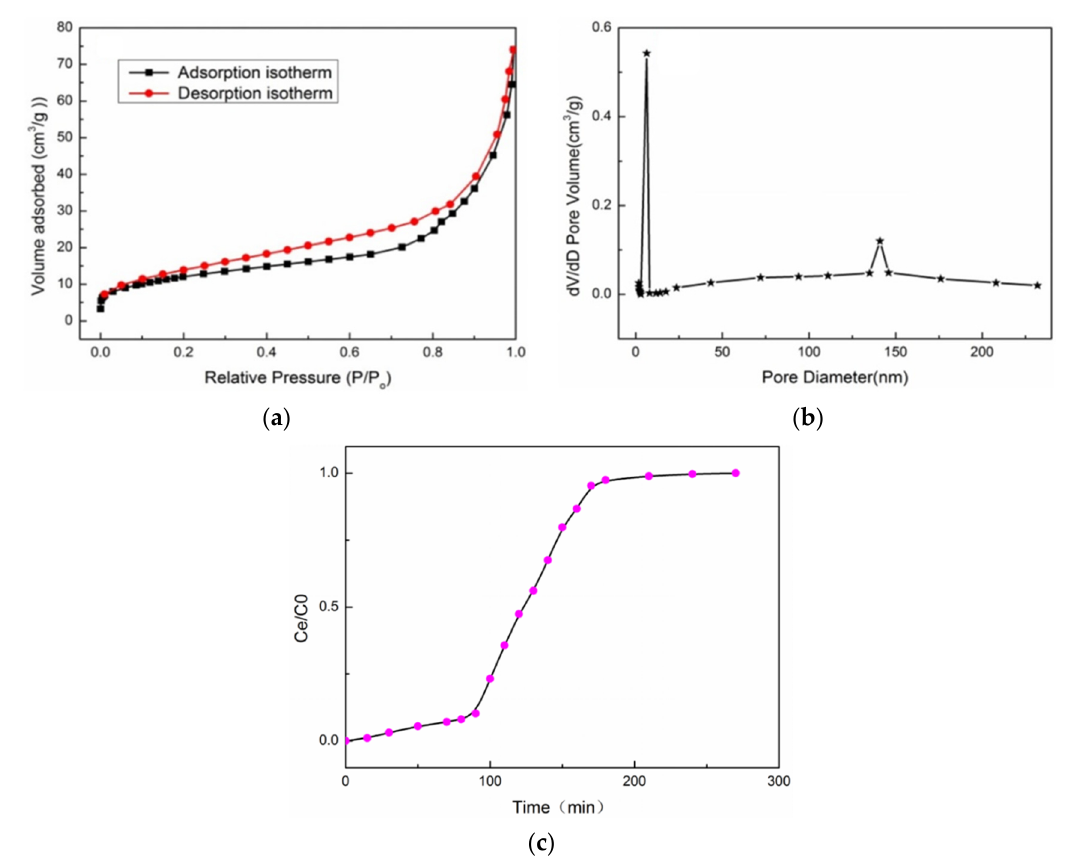
Figure 6. N 2 adsorption-desorption isotherms ( a ) and BJH pore size distributions ( b ), and penetration curve of azlocillin sodium ( c ).